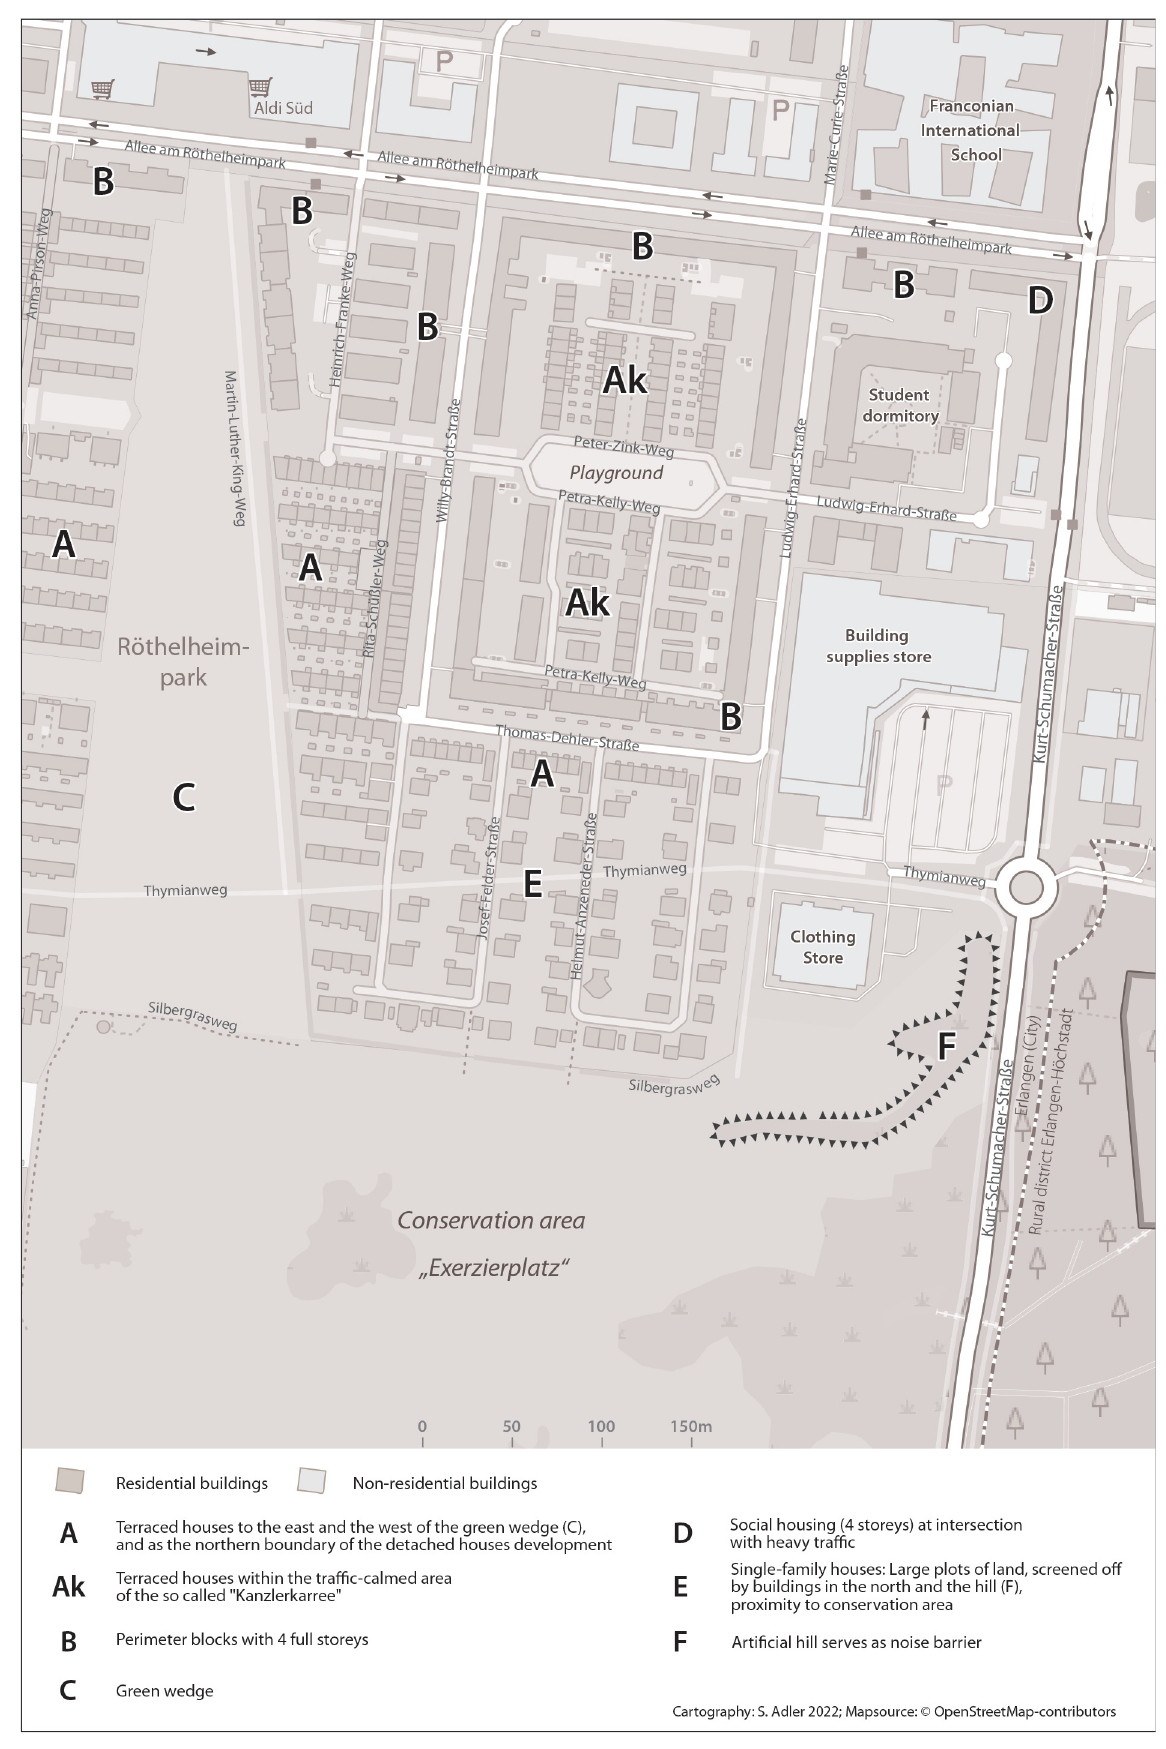
Figure 8. Residential building structure of a neighbourhood in